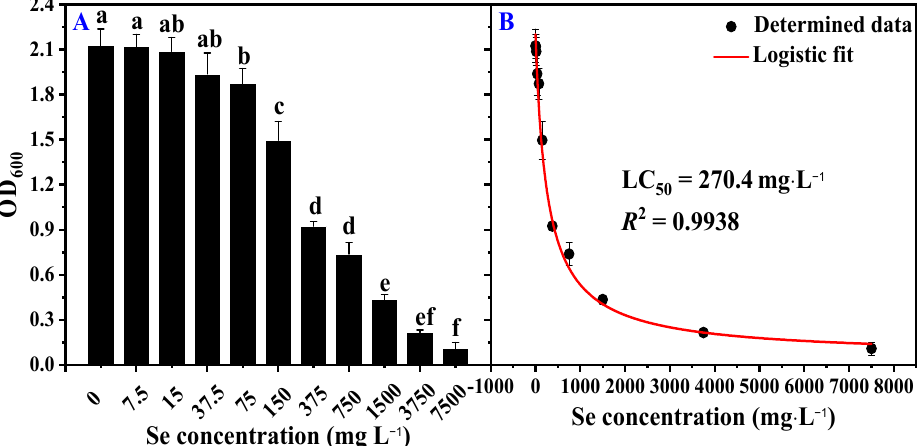
Figure 3. Se resistance of strain LWS1 grown in M9 medium containing SeIV for 24 h. Bacterial growth under different concentrations of Se from 0 to 7500 mg·L − 1 ( A ) and logistic fitting to calculate the LC 50 of Se to strain LWS1 ( B ). Different letters indicate significant differences between treatments based on two-way ANOVA by Tukey's multiple comparisons test at p ≤ 0.05.